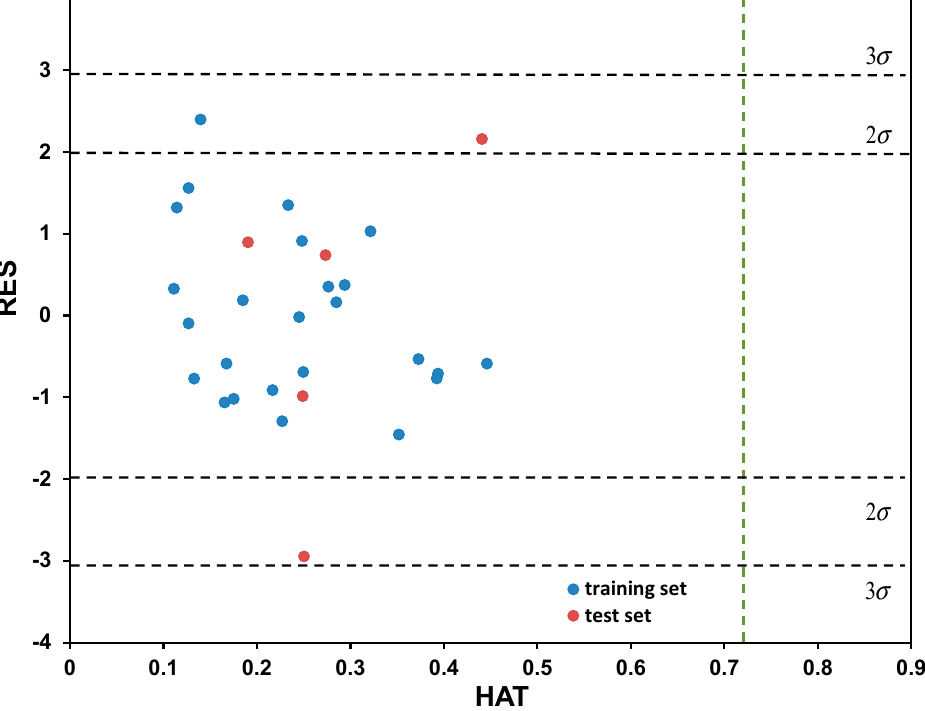
Figure 5. Determination of applicability domain (AD) for the five-variable model, selected as the best among tested, through Williams plot.